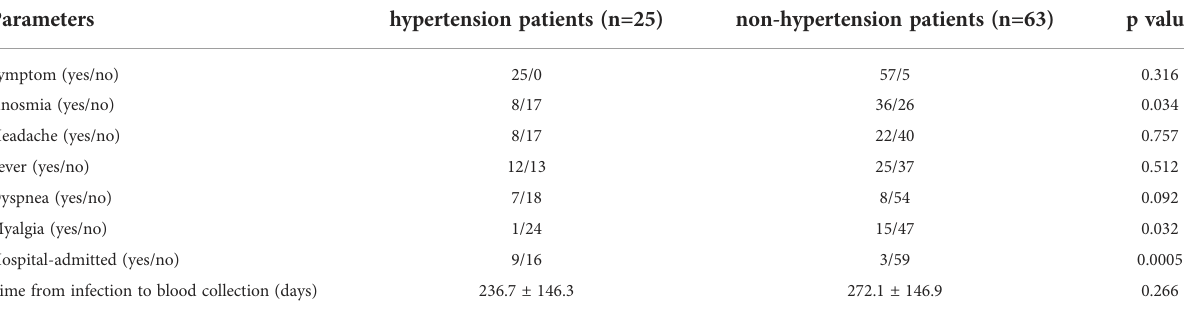
TABLE 3 Comparison of baseline symptoms and blood taking duration between SARS-CoV-2 infected patients with and without